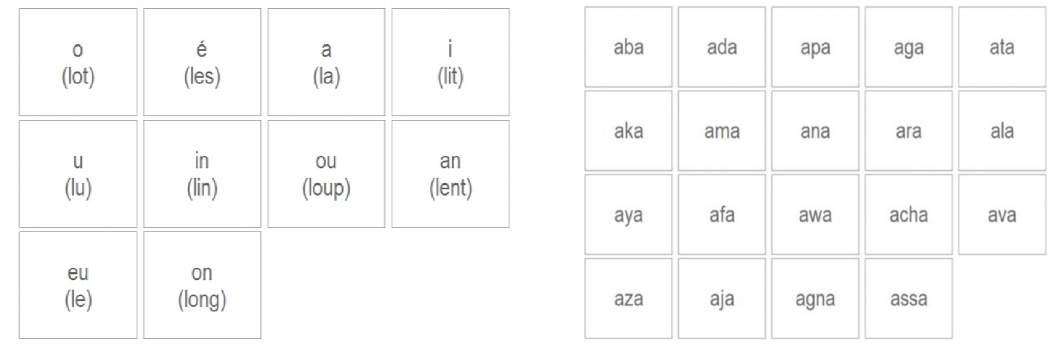
Fig 2. Response screens showing the stimuli used for the vowel (left) and consonant recognition tests (right) in